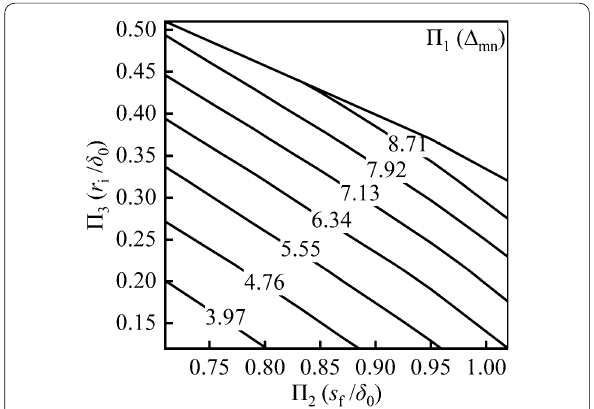
Figure 13 Contour map of the simulation results of the equivalent neutral layer offset ratio Δ